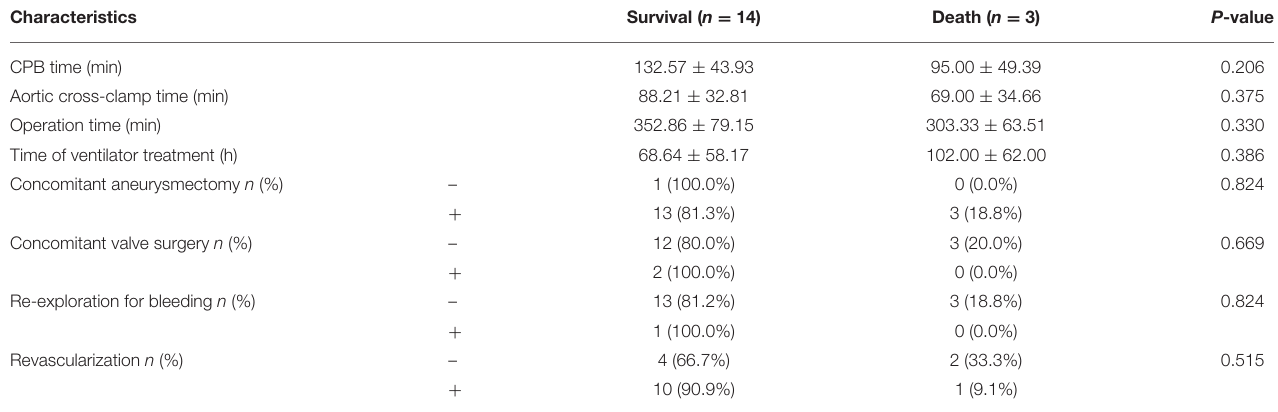
TABLE 4 | Surgical-related data of surgical patients.